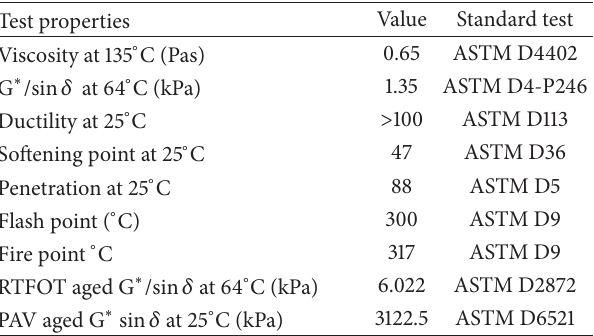
Table 1: Properties of base binder grade 80/100 penetration.